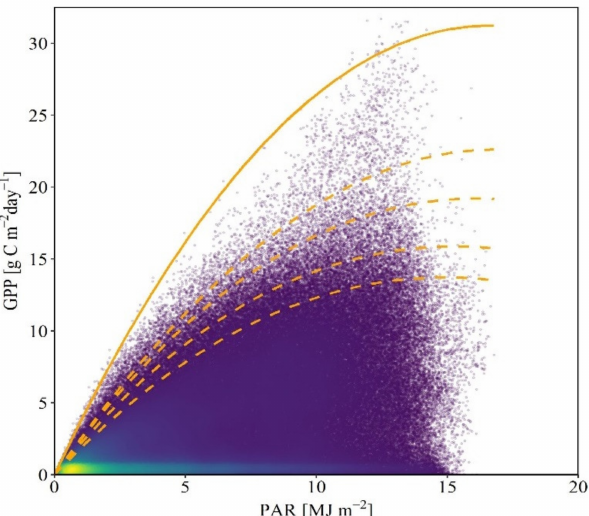
Figure 2. Schematic of PAR- E max based on the relationship between daily observed GPP and PAR. (The color from purple to yellow indicates that the point density increases gradually. The orange fit curve indicates the vegetation GPPmax at different PAR levels, and the dashed curves from top to bottom are fitted curves at the 99th, 98th, 95th, and 90th percentiles of GPP max . The fitted curve indicates the unconstrained ideal GPP, while the points below the curve indicate the true GPP constrained by vegetation physiology and environmental